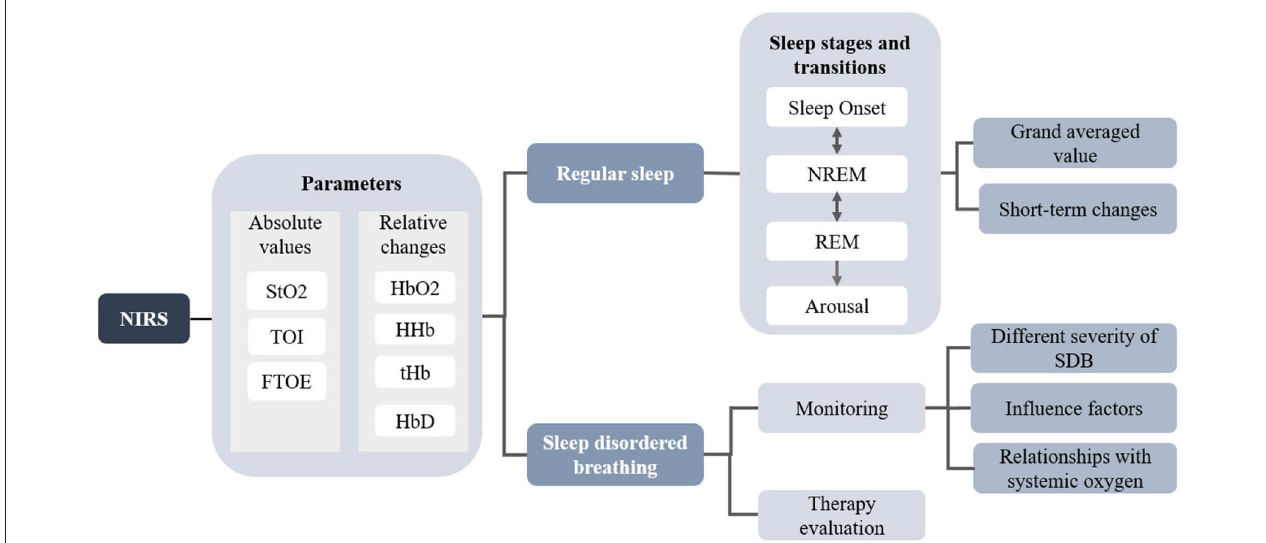
FIGURE 2 | The diagram of the application of NIRS in human sleep